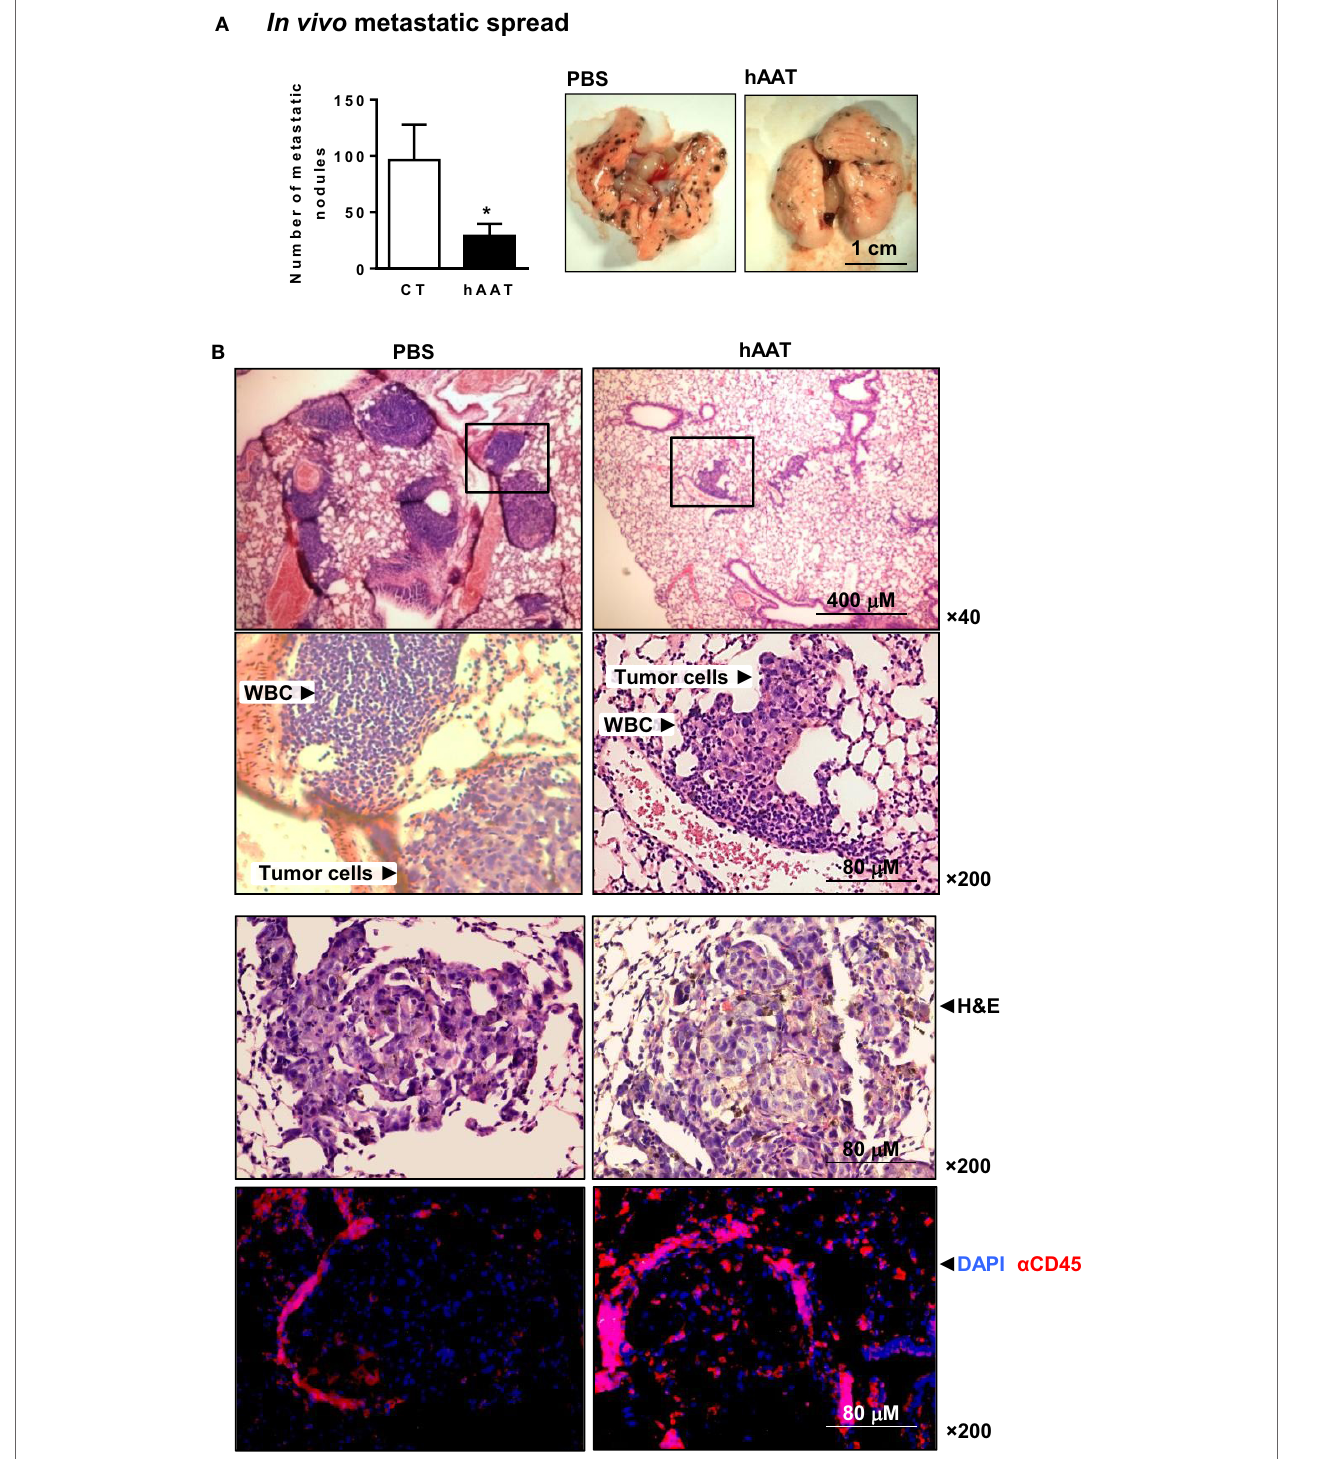
FigUre 2 | Diminished metastatic spread of B16-F10 cells in haaT-treated mice . (a) C57BL/6 mice ( n = 8 per group) were pretreated with hAAT (2 mg per animal) 24 h prior to inoculation with B16-F10 cells (1 × 106 cells per animal) and every third day afterward. Animals were sacrificed after 17 days. Lung metastatic nodules were counted by microsurgery. Mean ± SEM, * p < 0.05. Unpaired two-tailed Student’s t -test was employed to assess differences between groups. (B) Histological sections were taken 17 days post-inoculation. Representative photomicrographs of lung samples stained with H&E or immunofluorescently stained with DAPI and α